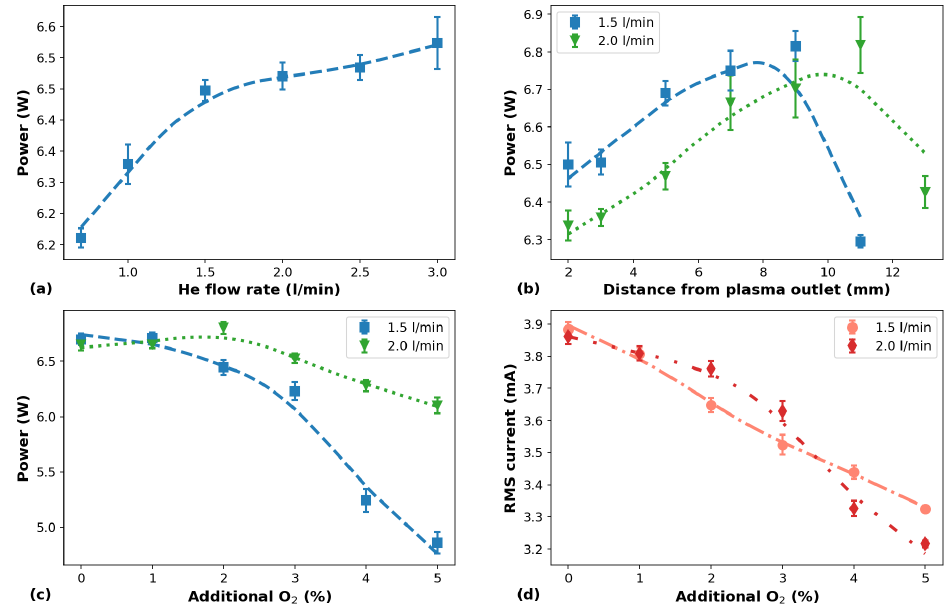
Figure 2. Curves of P dis as a function of the He flow rate ( a ) and distance between plasma outlet and target ( b ), and curves of P dis ( c ) and i RMS ( d ) as a function of the O 2 percentage added to the working gas. d = 7 mm in ( a , c , d ). O 2 content is zero in ( a , b